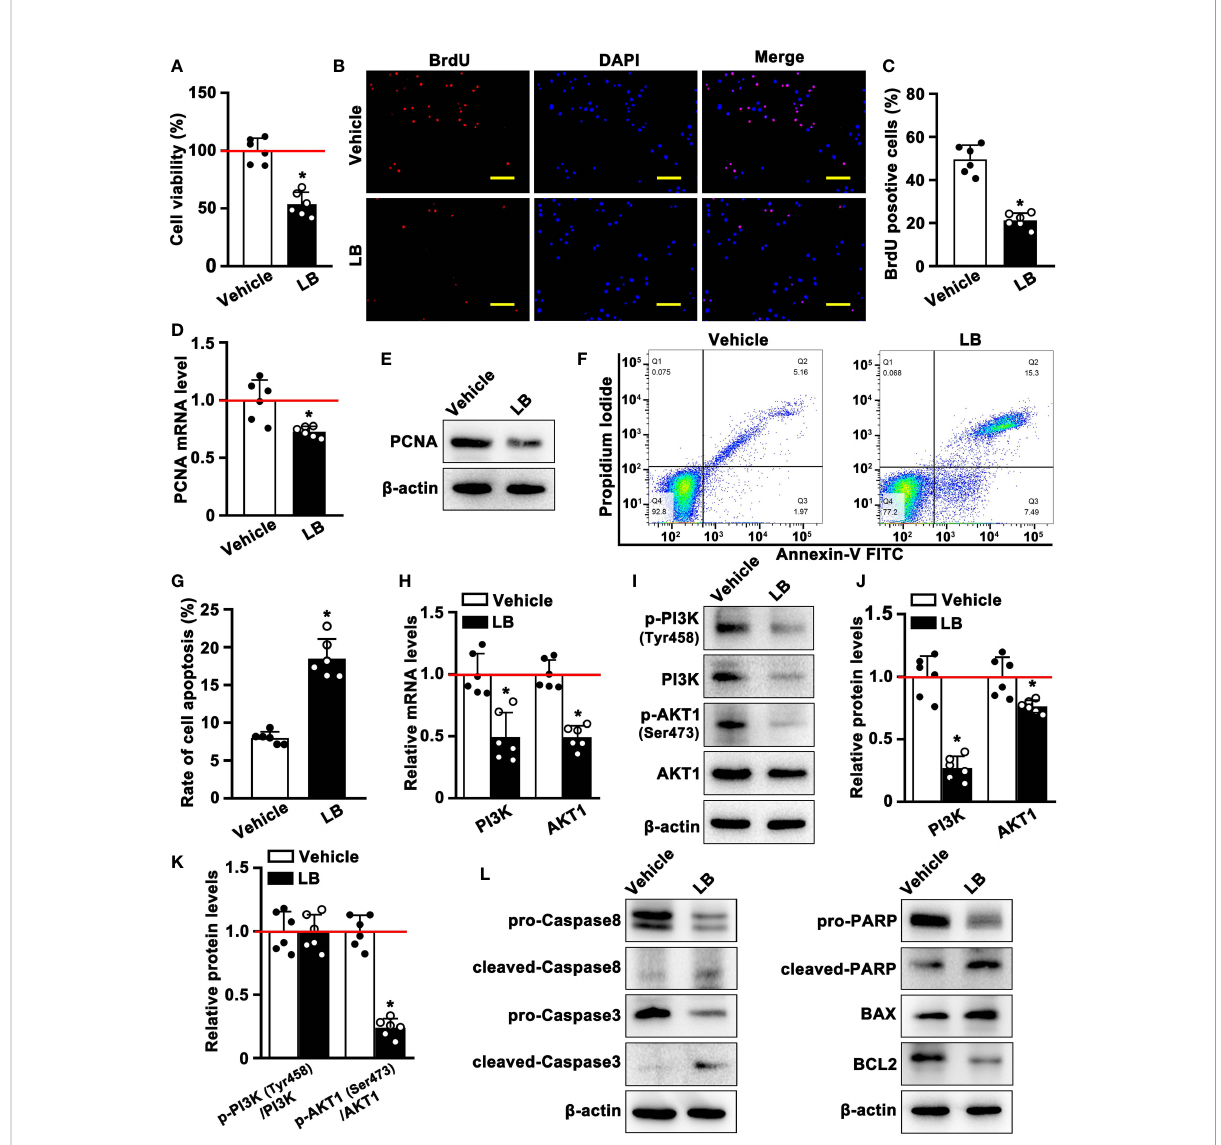
FIGURE 7 LB inhibits the proliferation and induces the apoptosis of A549 cells through the PI3K/AKT1 pathway in vitro . (A) Effects of LB on cell viability. A549 cells were seeded in 96-well plates and treated with LB (80 m g/ml) or vehicle for 24 h (n=6 each), and cell viability was assessed by CCK8 assays. (B, C) Effects of LB on cell proliferation. A549 cells were incubated with BrdU (0.96 mM) for 8 h, followed by treatment with LB (80 m g/ ml) or vehicle for 24 h (n=6 each). The bar represents 100 m m. (D) Effects of LB on PCNA expression. A549 cells were treated for 24 h with LB (80 m g/ml) or vehicle (n=6 each). Relative PCNA mRNA expression was analyzed by qRT-PCR, with GAPDH mRNA serving as an internal reference, (E) and PCNA protein expression was analyzed by western blotting. (F, G) Effects of LB on A549 cell apoptosis. A549 cells were treated with LB (80 m g/ml) or vehicle for 24 h (n=6 each), followed by double staining with Annexin V-FITC and PI and detection of apoptotic cells by fl ow cytometry. (H) Effects of LB on PI3K and AKT1 mRNA expression. A549 cells were treated with LB (80 m g/ml) or vehicle for 24 h (n=6 each), and relative PI3K and AKT1 mRNA expression levels were analyzed by qRT-PCR, with GAPDH mRNA serving as an internal reference. (I – K) Effects of LB on the expression of p-PI3K (Tyr458), PI3K, p-AKT1 (Ser473) and AKT1. A549 cells were treated with LB (80 m g/ml) or vehicle (n=6), and protein expression was analyzed by western blotting. (L) Effects of LB on the expression of Caspase8, Caspase3, PARP, BCL2, and BAX. A549 cells were exposed to LB (80 m g/ml) for 24 h, followed by western blotting analysis of protein expression, with b -actin serving as the protein loading control. Data are expressed as mean ± SEM. *P<